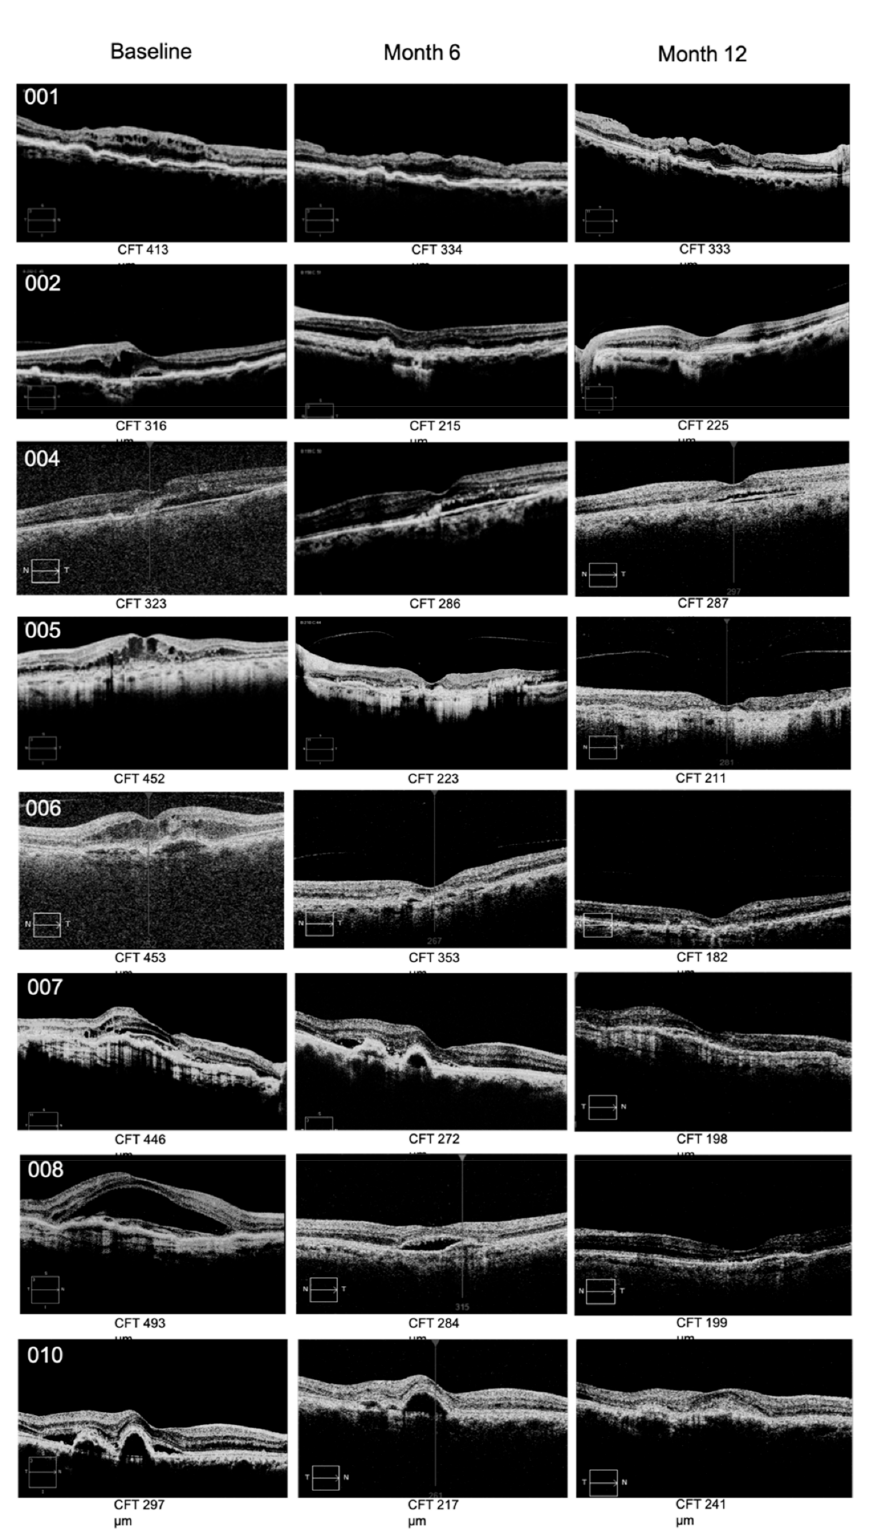
Figure 2. Representative images of CFT by OCT at baseline, month 6, and month 12 of the follow-up period for subjects included in the RBZ-TALF group. All patients showed a consistent and progressive reduction in CFT by month 12. CFT, central foveal thickness; OCT, optical coherence tomography; RBZ, ranibizumab; TALF, triamcinolone acetonide-loaded liposome